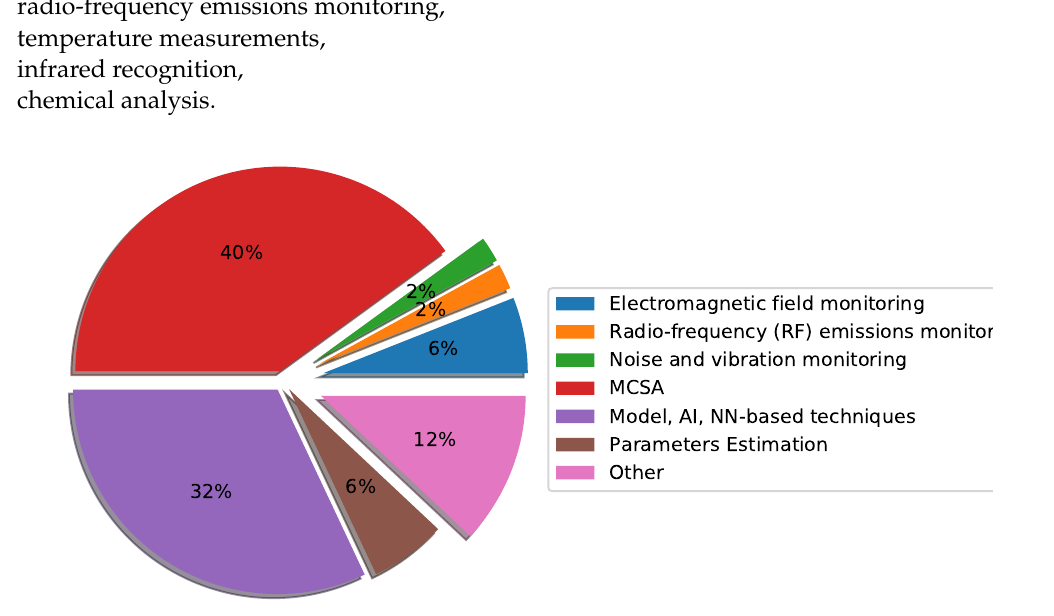
Figure 5. Distribution articles according to the used